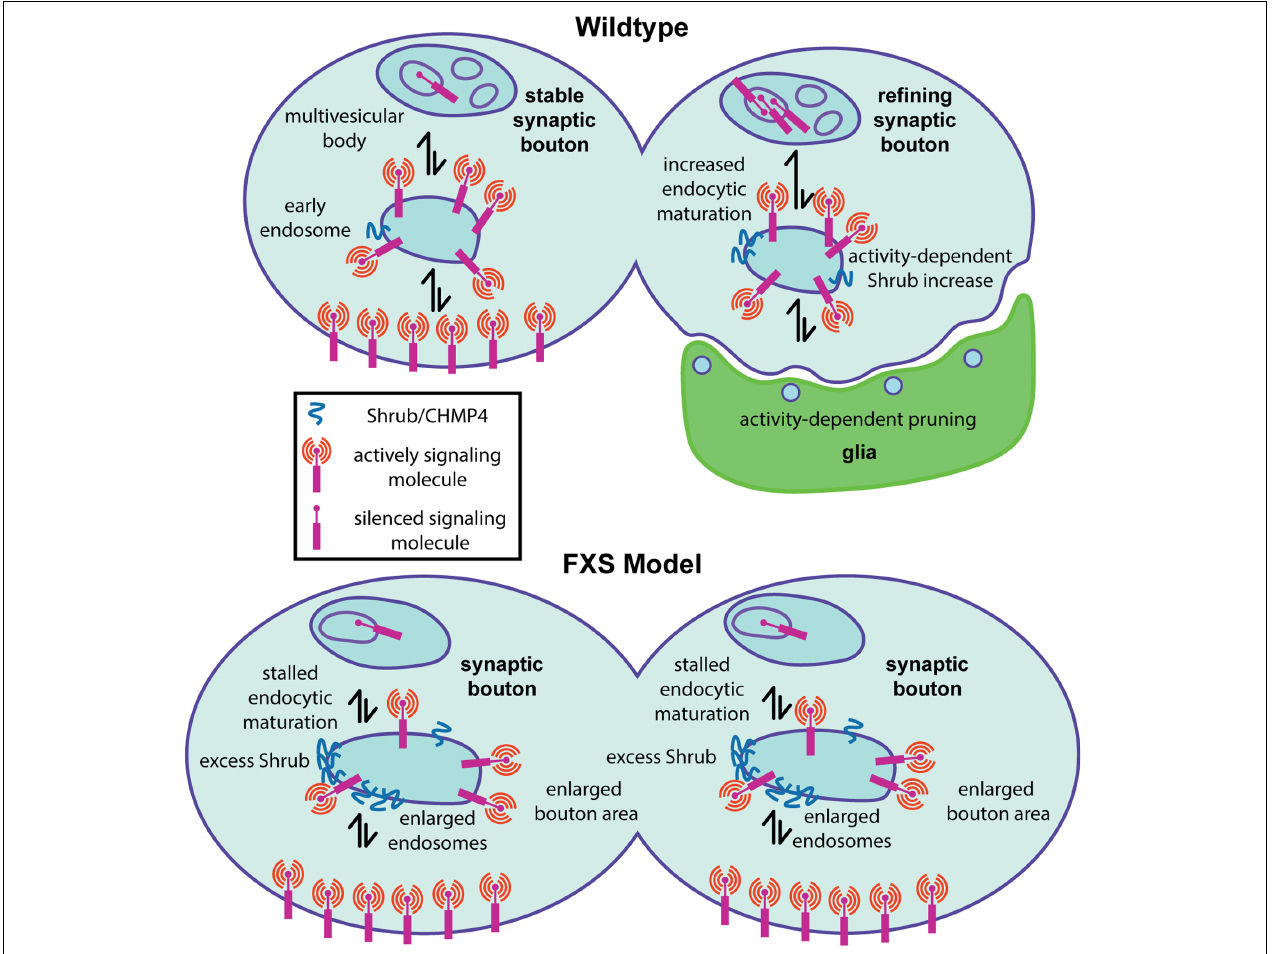
FIGURE 2 | Presynaptic endosomal membrane trafficking defects in the Drosophila FXS model. Diagram summarizing a new fragile X mental retardation protein (FMRP) role in the regulation of presynaptic membrane trafficking by the ESCRTIII core component Shrub/CHMP4. (Top) In wildtype animals, appropriate Shrub levels mediate endosomal membrane trafficking within presynaptic boutons, which is required for activity-dependent synaptic pruning/refinement. It is hypothesized that activity-dependent endosomal trafficking regulates the presentation of surface signaling molecules that trigger phagocytosis by glia (green) during the early-use critical period. (Bottom) In the FXS disease model, excess Shrub translation leads to stalled endosomal membrane trafficking defects, resulting in enlarged endosomes within presynaptic boutons. It is hypothesized that impaired membrane signaling regulation via inappropriate presentation of surface cues driving glial phagocytosis prevents appropriate activity-dependent synaptic